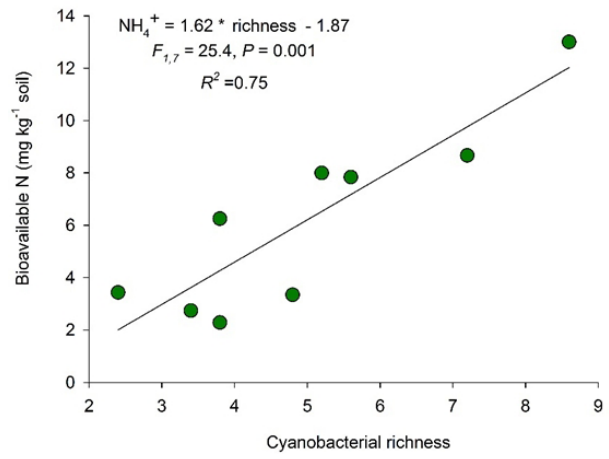
Figure 6. Relationship between bioavailable N and cyanobacterial richness over nine time